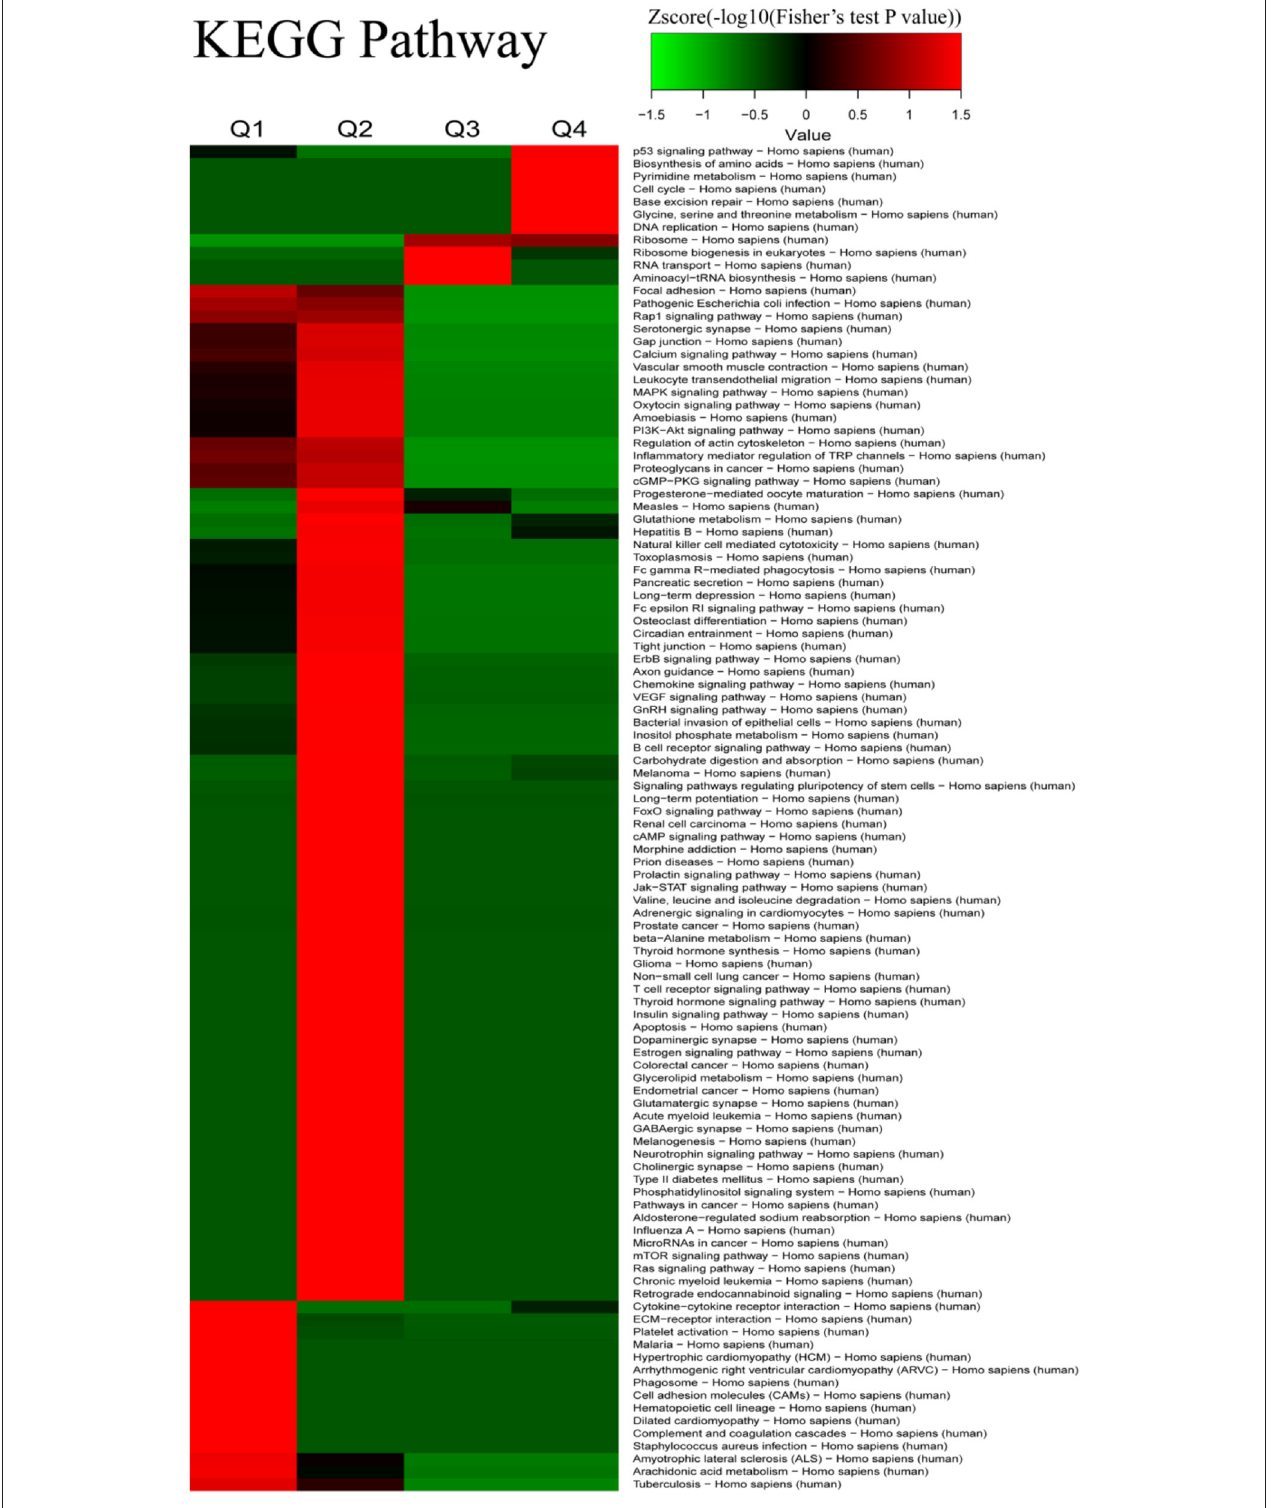
FIGURE 4 | The Kyoto Encyclopedia of Genes and Genomes (KEGG) pathway-based clustering analysis for the differentially expressed proteins between iTfh cells and naive CD4 + T cells.